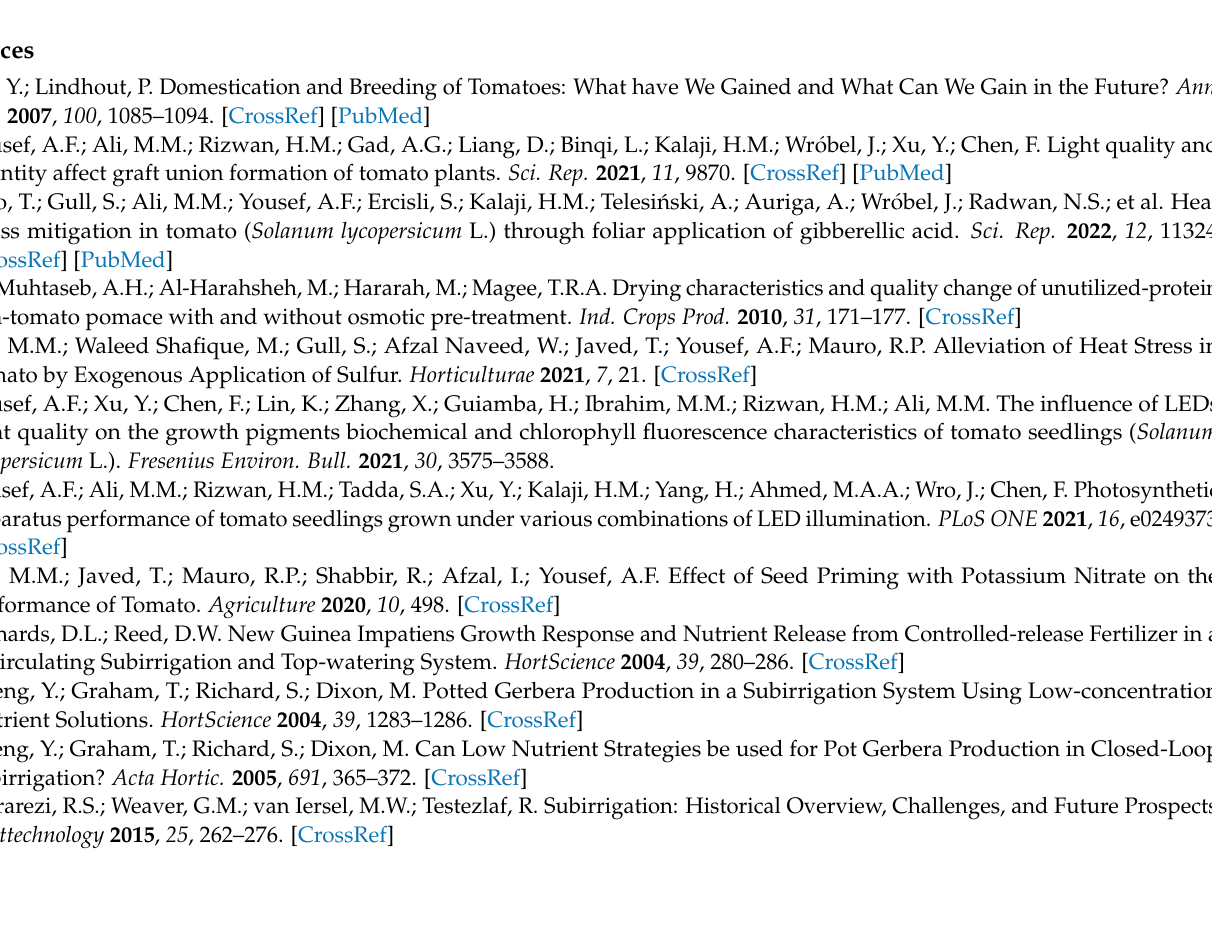
DAPs; Table S2: The KEGG annotation of identified proteins; Table S3: DAPs participated in car- bohydrates and energy metabolism; Table S4: DAPs participated in stress resistance and defense response; Table S5: DAPs participated in amino acid metabolism; Table S6: DAPs participated in plant hormones and secondary